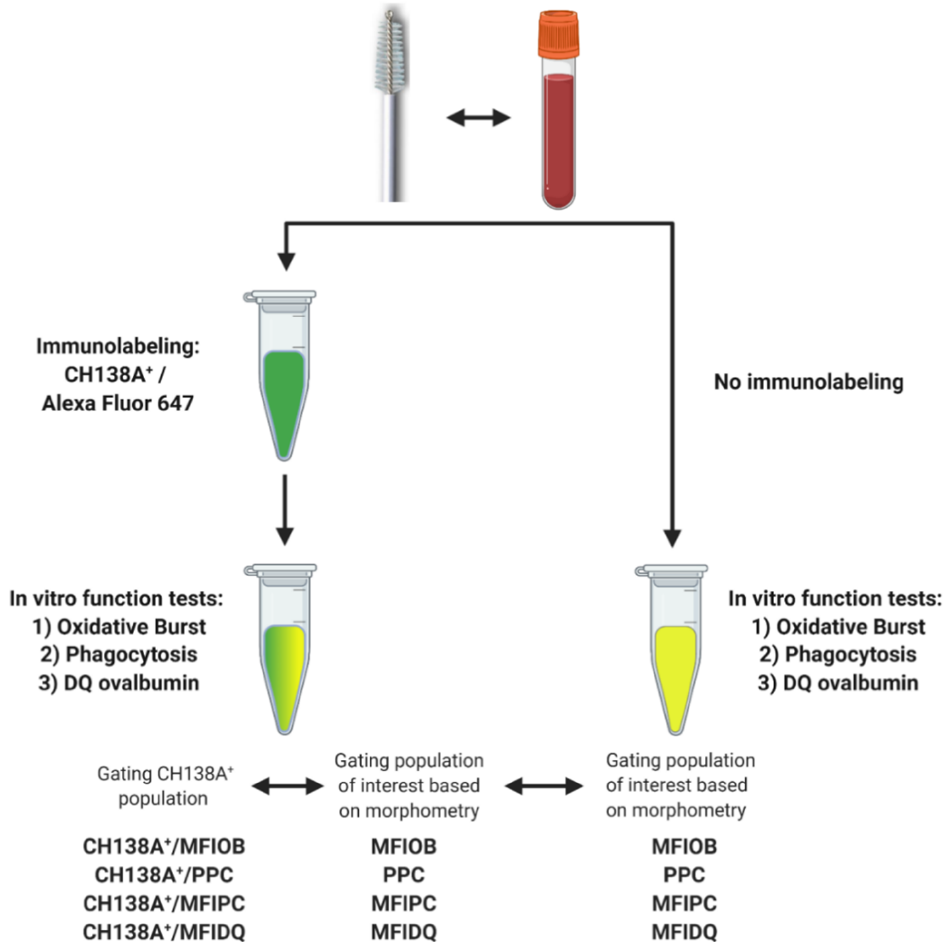
Figure 2. Experimental setup for blood and endometrial polymorphonuclear leukocyte (PMN) functionality tests assessing PMN oxidative burst (OB), phagocytosis (PC), and intracellular proteolytic degradation by DQ-ovalbumin (DQ-ova). Blood and endometrial samples ( n = 11) were collected from Holstein-Friesian cows at 9–37 days in milk. The PMN functionality tests were performed in duplicate, once with prior CH138A immunolabeling and once without CH138A immunolabeling (CH138A = bovine granulocyte marker). In samples with CH138A immunolabeling, we compared the functionality outcome intra-assay of CH138A + events versus a gating strategy solely based on the morphometric characteristics high forward scatter (FSC) vs. high side scatter (SSC). An inter- assay comparison was made between immunolabeled PMN and non-immunolabeled PMN, gating PMN solely based on the morphometric characteristics high FSC and high SSC. Figure created with BioRender.com (accessed on 10 February